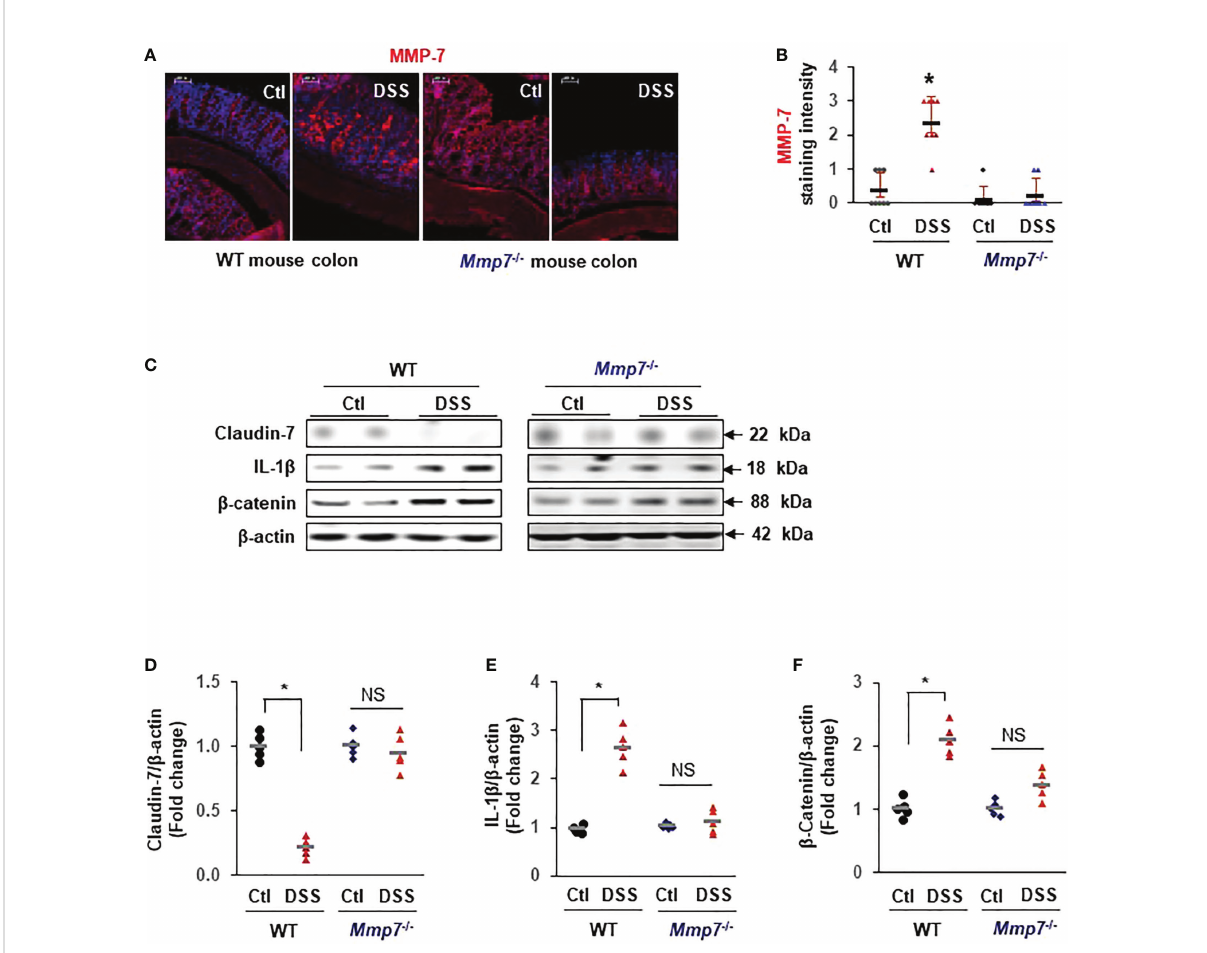
FIGURE 6 MMP-7 knockout prevents DSS-induced suppression of Claudin-7 in the colon. C57BL/6 and Mmp7 -/- mice received 3% DSS in drinking water for 7 days as shown in Figure 4. Full thickness colon tissue was fi xed in formalin for immunohistochemical analysis or snap-frozen in liquid nitrogen for immunoblot analysis. (A) Representative images of immuno fl uorescence staining for MMP-7 in the colons of C57BL/6 and Mmp7 -/- mice treated with or without DSS. (B) Quanti fi cation of MMP-7 staining intensity. (C) Representative images of WB for indicated proteins in the colon. (D – F) Protein expression levels determined by densitometry. Arbitrary optical density units of the targeting proteins were normalized vs b -actin and presented as fold change. n=5. * p <0.01 vs WT control. NS, not signi fi